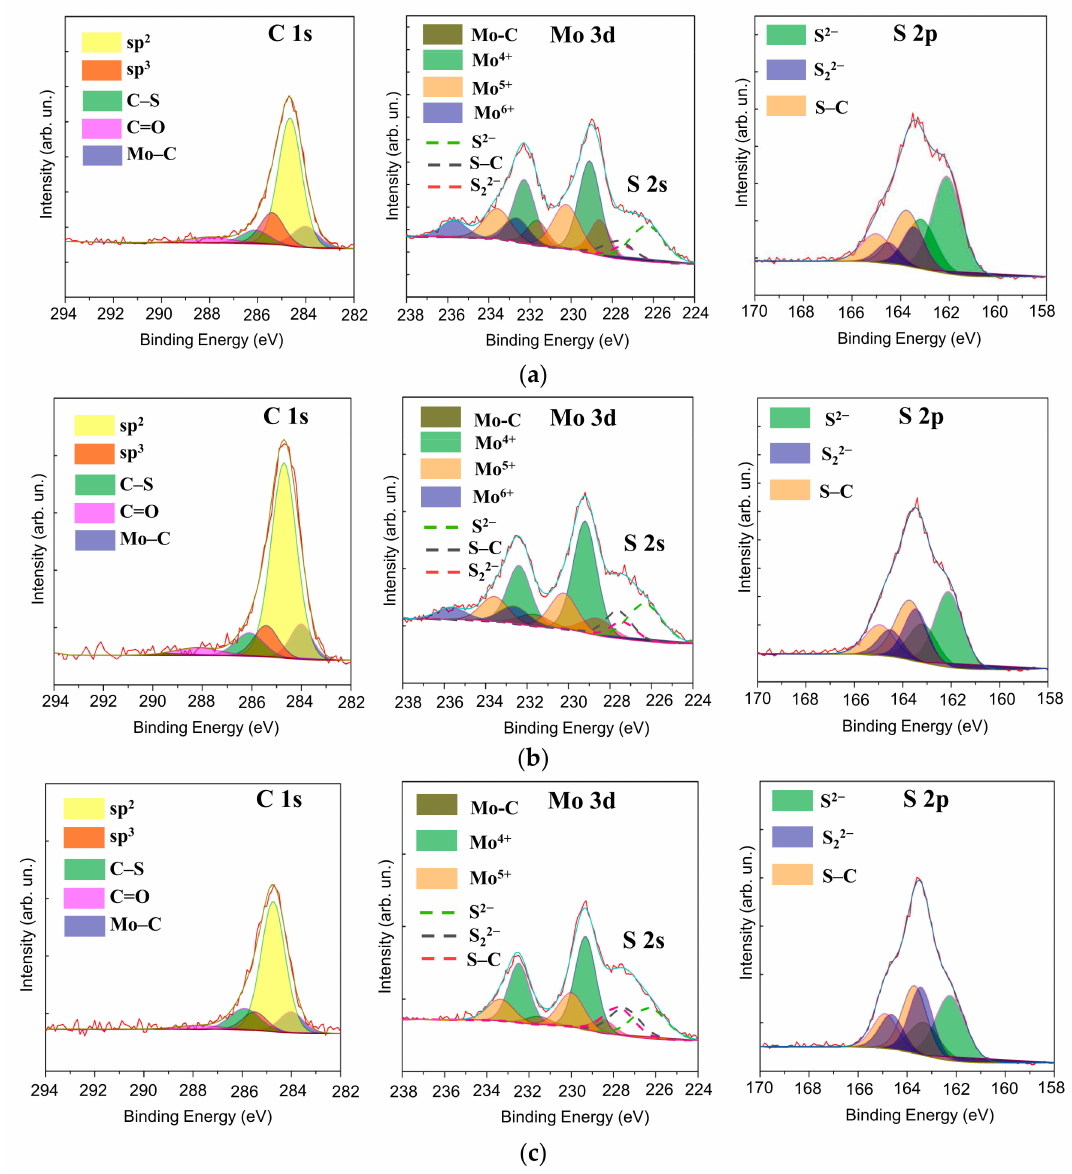
Figure 7. XPS spectra of C 1s, Mo 3d, and S 2p which were measured on the surface of the Mo–S–C–H thin-film coatings obtained by reactive PLD at H 2 S pressures of ( a ) 5.5, ( b ) 9, and ( c ) 18 Pa. For Mo 3d spectra, the S 2s spectra of di ff erent S species are